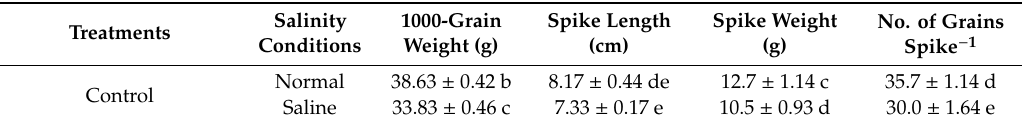
Table 2. The impact of BAZ ( Bacillus augmented ZnO)-coated urea on yield parameters of wheat under salinity